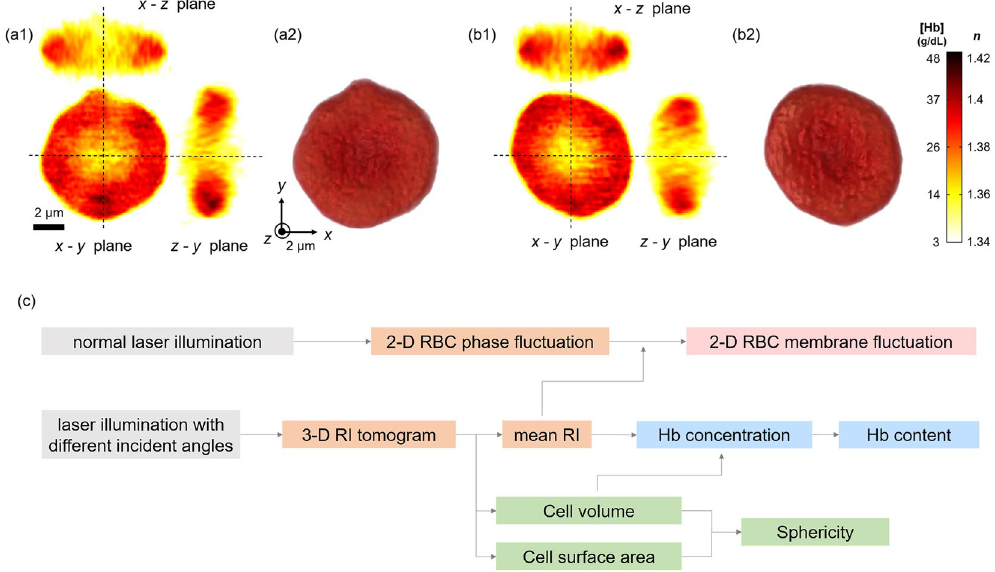
Figure 1. ( a , b ) Reconstructed 3-D RI tomograms and isosurface renderings of representative non-diabetic and diabetic RBCs. Cross-sectional images (along the x - y , the z - y and the x - z planes) of the 3-D RI tomogram of the representative non-diabetic ( a1 ) and diabetic ( b1 ) RBCs. RI isosurfaces ( n > 1.35) of the corresponding non- diabetic ( a2 ) and diabetic ( b2 ) RBCs were presented. ( c ) Flow diagram for retrieval of six RBC